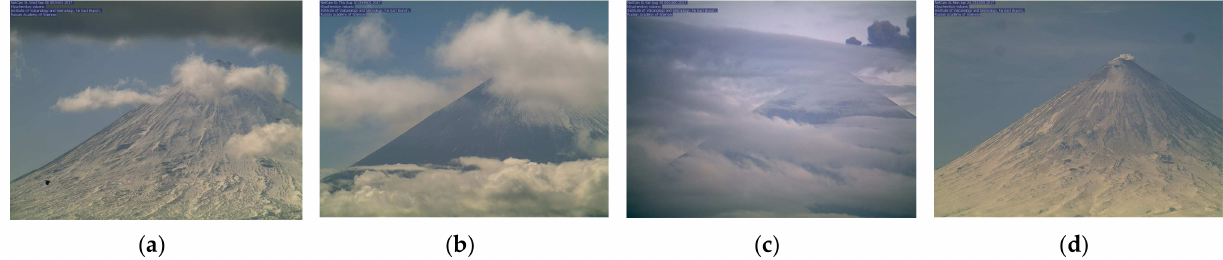
Figure 17. Examples of incorrectly classified scenes of Klyuchevskoy volcano: ( a ) image with true label ‘clear’ classified as